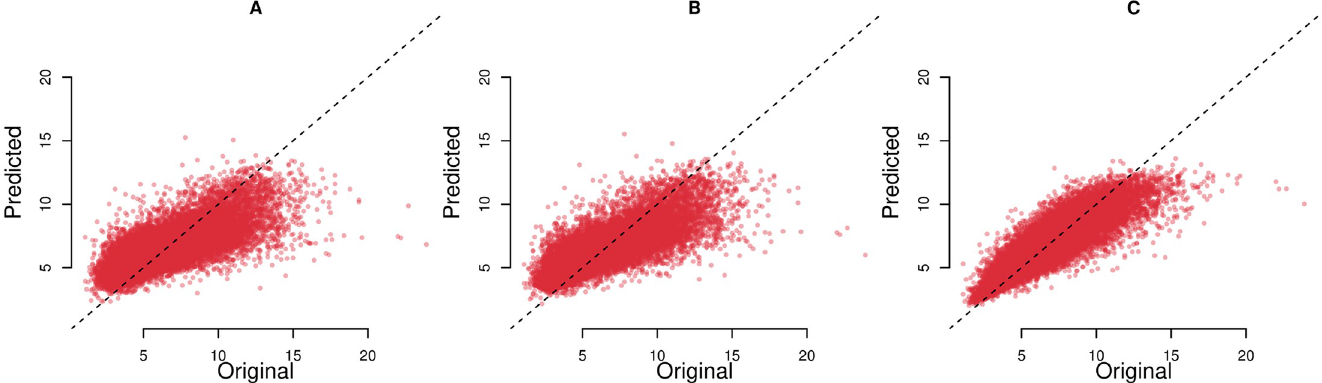
Fig 4. Predicted against original prevalence of COPD. A: Model based on search queries. B: Model based on search queries and land cover data. C: Model based on search queries, census and land cover data. Each point denotes a distinct census tract in the dataset. Dotted line represent x = y.